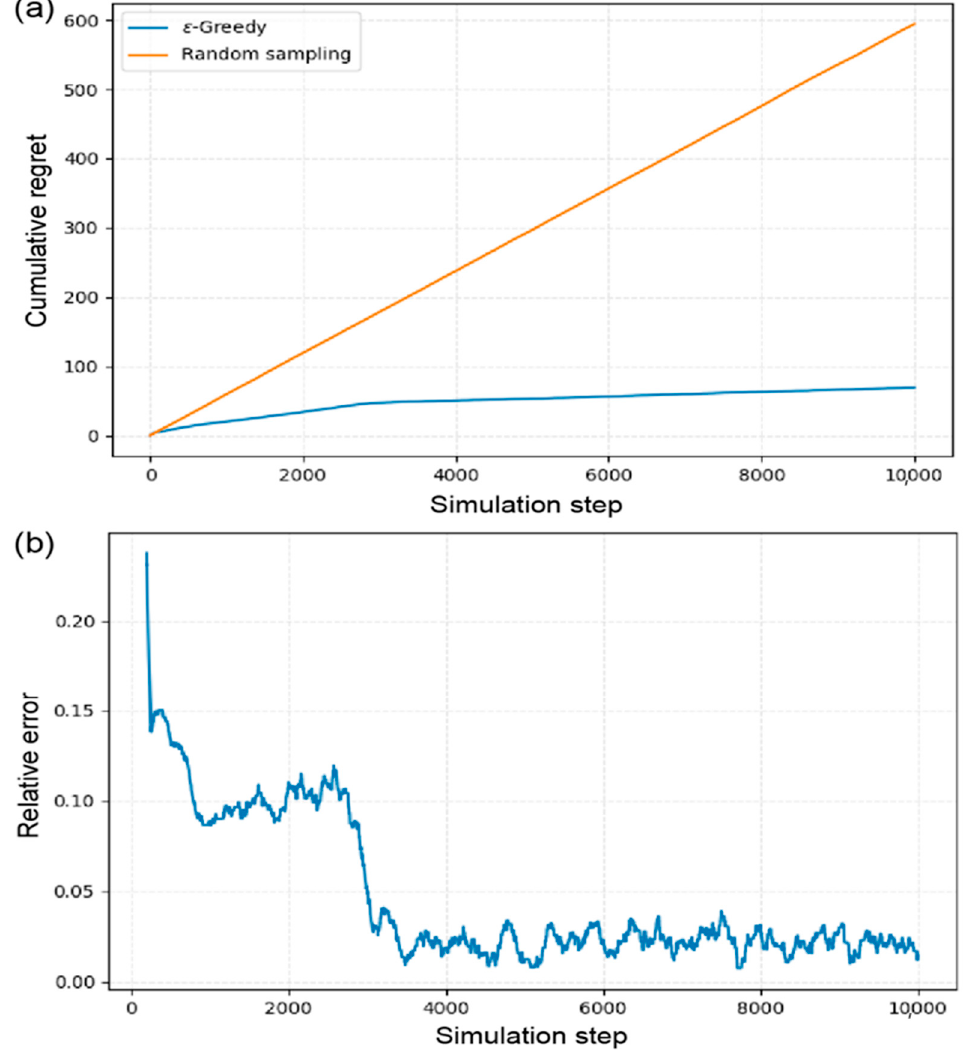
Figure 5. (a) Cumulative reward with simulation numbers. (b) Moving average of the relative error Figure 5. ( a ) Cumulative reward with simulation numbers. ( b ) Moving average of the relative error between the optimal reward and the actual reward according to the number of simulations. between the optimal reward and the actual reward according to the number of